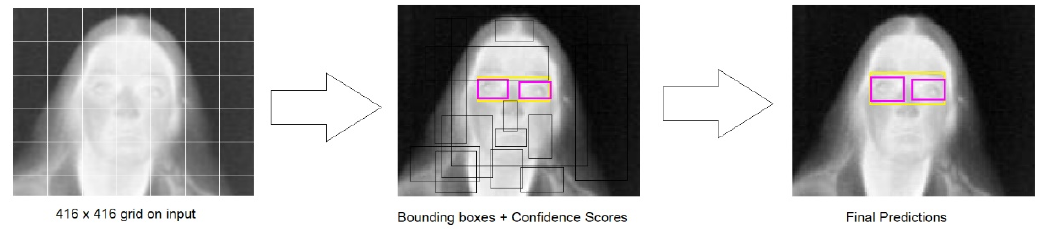
Figure 12. The models’ processing steps on the input image.